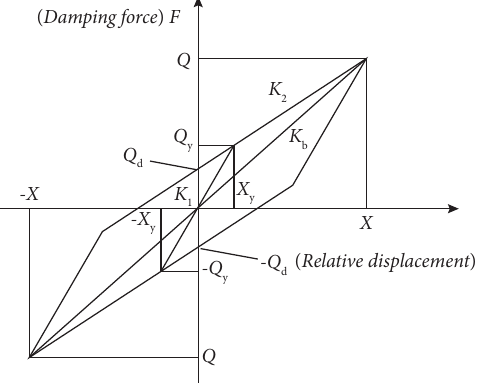
Figure 4: Equivalent bilinear restoring force model of the